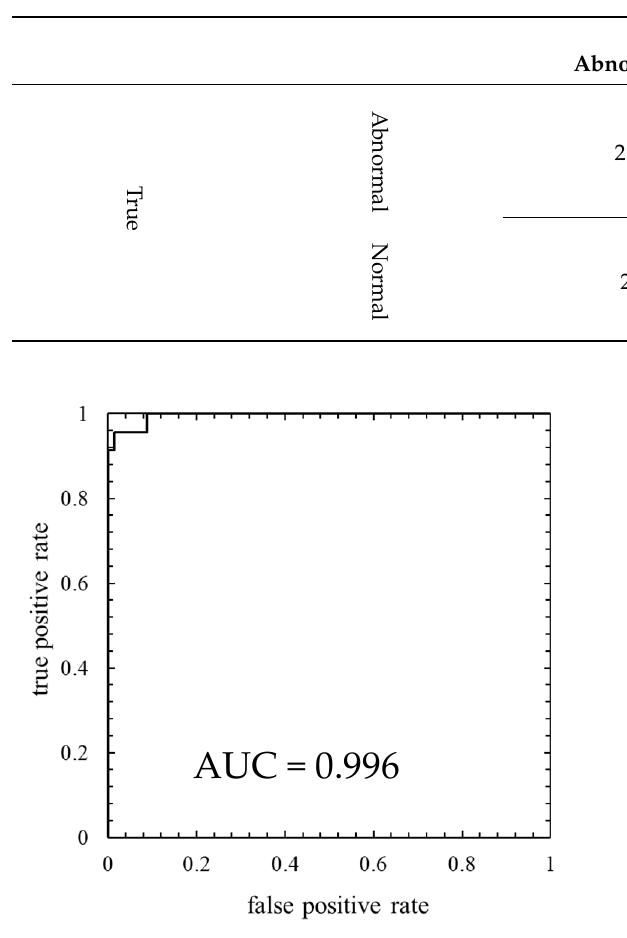
Table 7. Confusion matrix of the model in which the number of mixture components K was 256 (threshold is 100th percentile’s value).